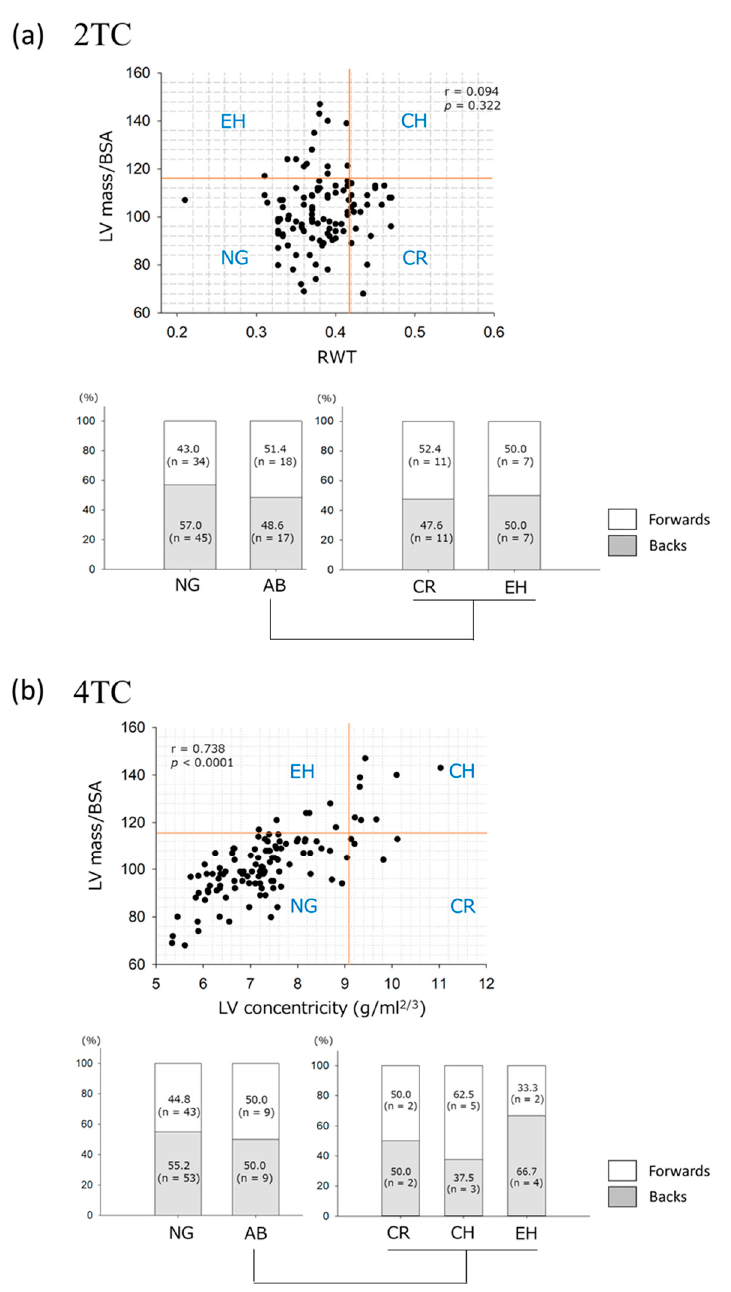
Figure 2. Left ventricular geometry evaluated by ( a ) 2- and ( b ) 4-tiered classifications in young Japanese rugby athletes. The left ventricular geometry is classified according to the thresholds indicated by the red lines. NG, normal geometry; AB, abnormal geometry including concentric remodeling (CR), concentric left ventricular hypertrophy (CH), and eccentric left ventricular hypertrophy (EH); BSA, body surface area.